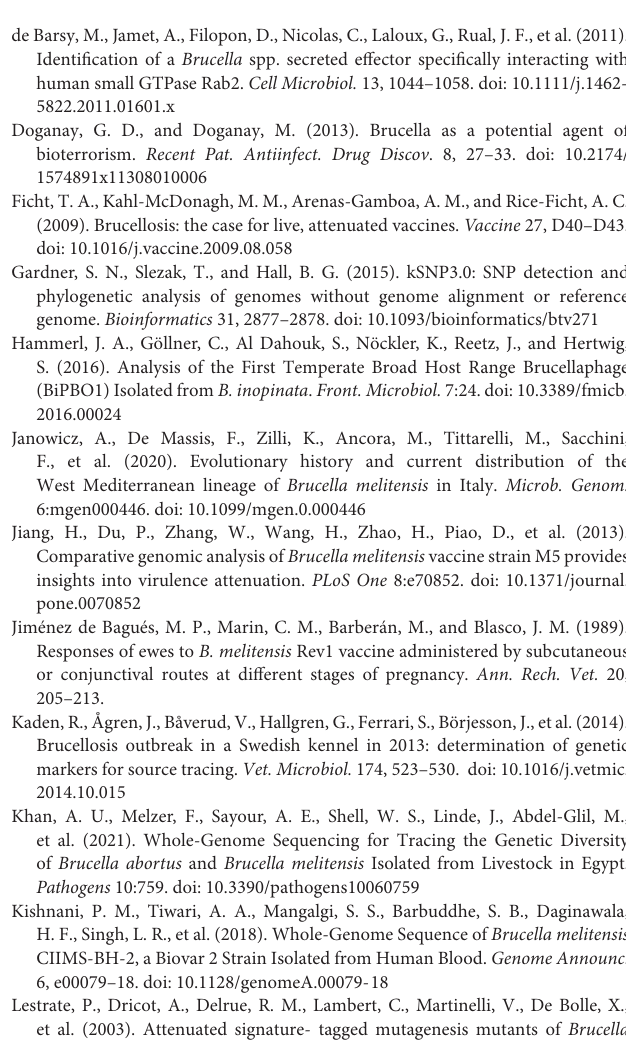
Supplementary Table 2 | Metadata of Indian strains ( n = 17) and vaccines strains Rev.1 and M5. Supplementary Table 3 | Gene presence and absence as per pangenome analysis. Supplementary Table 4 | COG annotation and classification of accessory genes in pangenome analysis. Supplementary Table 5 | MLST profiling of the genome analyzed. Supplementary Table 6 | Table containing information regarding gubbins recombination